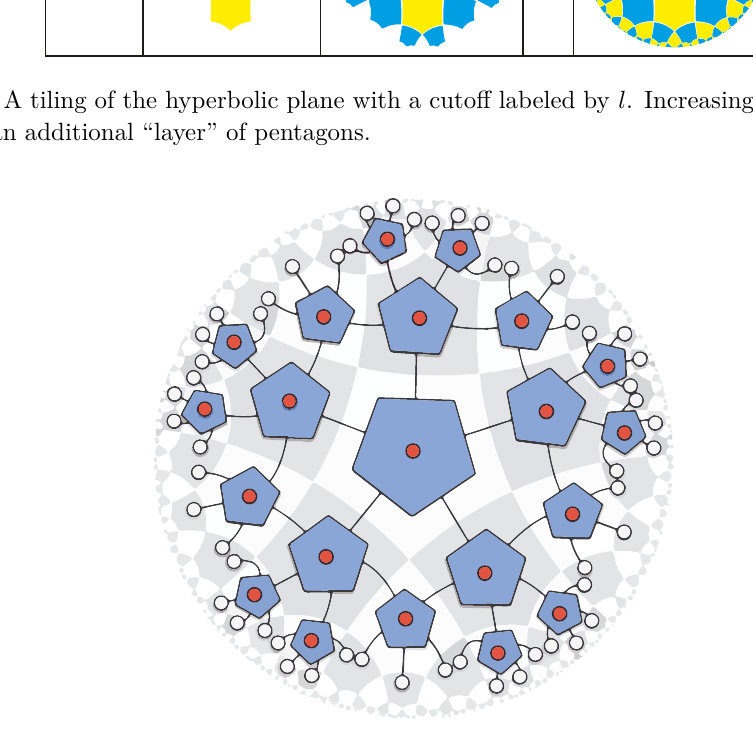
Figure 7. An example of a HaPPY code with cut off at l = 2 . A blue pentagon represents an individual tensor. Each tensor’s six legs, each of which represents a single qubit Hilbert space, are represented by the red dot on top of it and the five black lines coming out of it. The red dot legs are treated as inputs, and the legs terminating in a white dot as outputs. Legs which terminate at tensors on both sides are refereed to as “virtual legs”. (This and similar subsequent figures are adapted from those in ref.